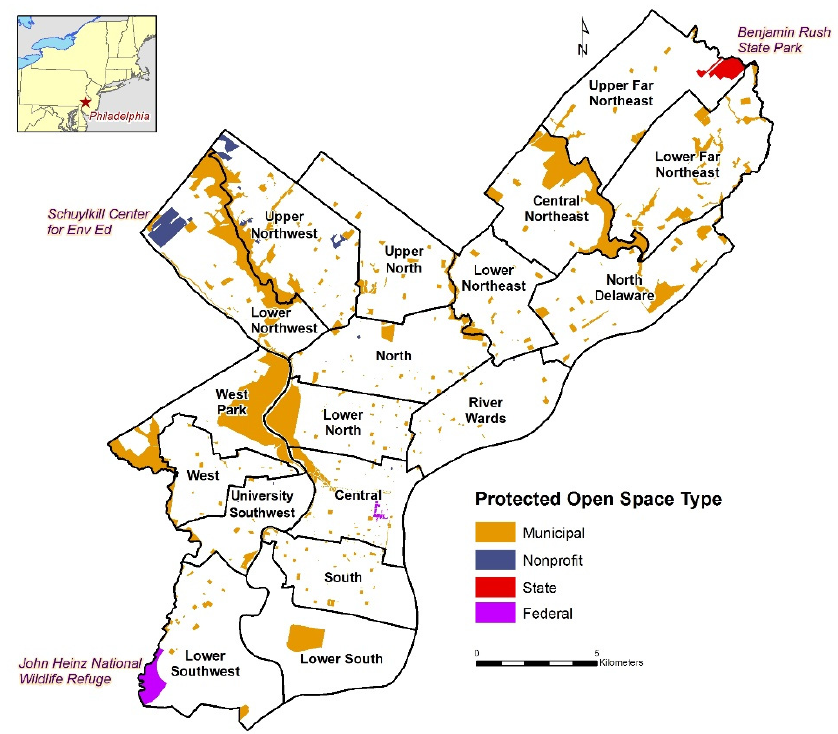
Figure 1. Geographic units used in our analysis of land cover change in Philadelphia. Table 1. Aerial photos used to assess land cover. Images were obtained from the Pennsylvania Spatial Data Clearinghouse (PASDA) and the Delaware Valley Regional Planning Commission (DVRPC).